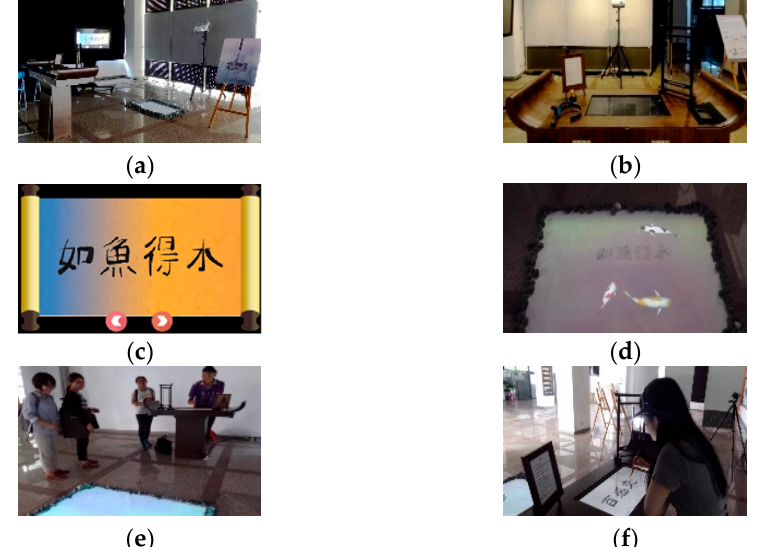
Figure 9. The public exhibition environment of the second experiment. ( a ) The exhibition hall. ( b ) Decoration of the table for calligraphy with the touch screen affixed to the table. ( c ) A completed calligraphic work seen on the display screen. ( d ) A calligraphic work superimposed on an animation shown in the interaction pool. ( e ) Some observers by-standing at the interaction pool. ( f ) A writer conducting calligraphy on the touch screen. Table 10. Observation results collected from the public exhibition of the second experiment.